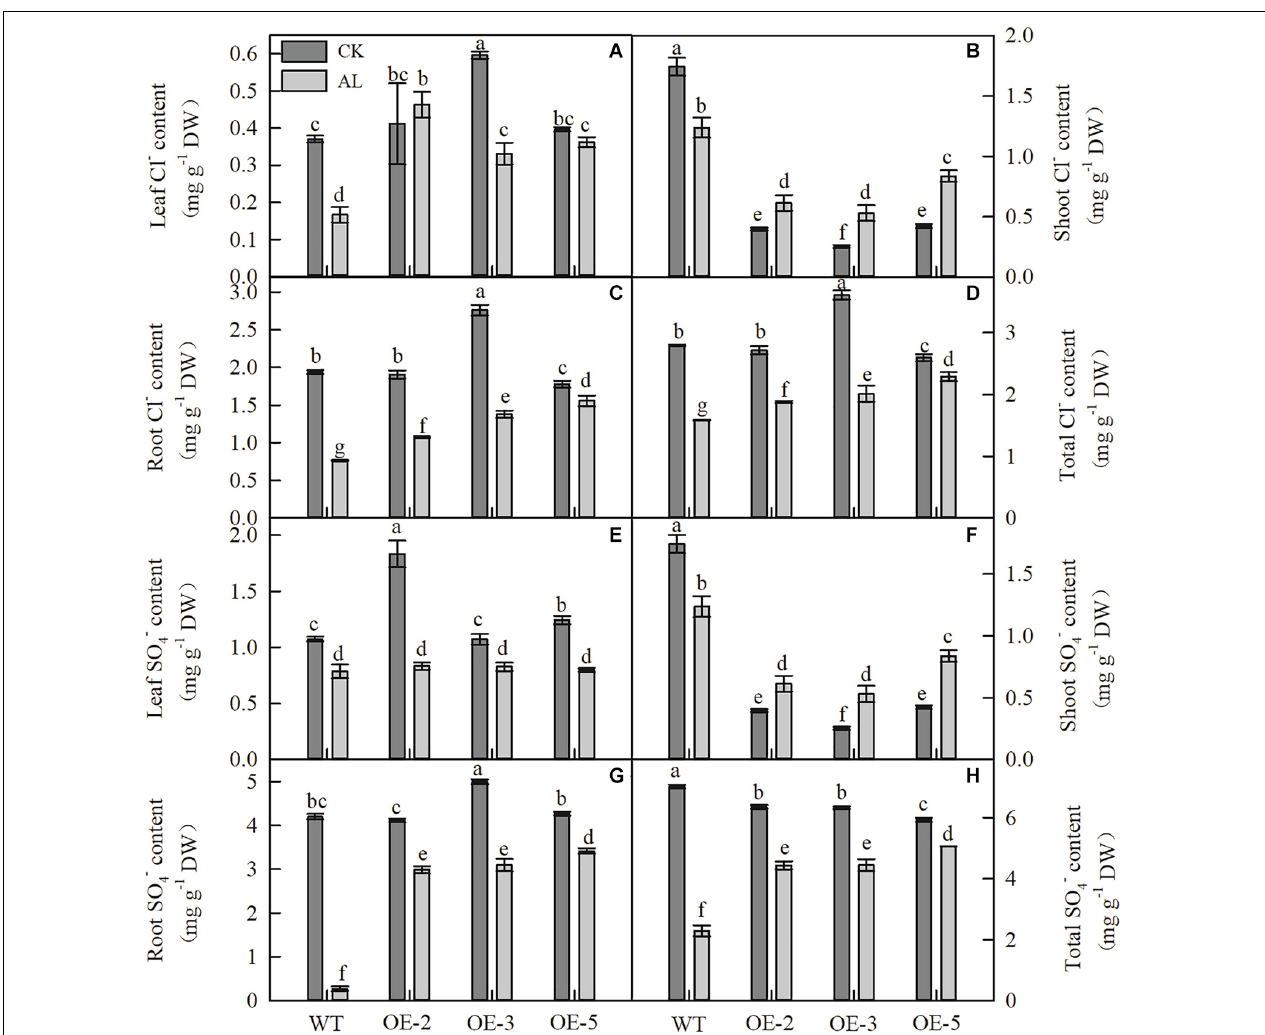
FIGURE 6 | MdTyDc overexpression changed the Cl − and SO 42 − content in apple plants after 15 days under control and alkaline conditions. (A) Leaf Cl − content, (B) shoot Cl − content, (C) root Cl − content, (D) total Cl − content, (E) leaf SO 42 − content, (F) shoot SO 42 − content, (G) root SO 42 − content, and (H) total SO 42 − content. The data are presented as means ± SD ( n = 3). Significant differences between WT and MdTyDc overexpression lines are indicated by different lowercase letters based on Tukey’s multi-range test ( P < 0.05). WT, wild type. OE-2, MdTyDc overexpression line 2. OE-3, MdTyDc overexpression line 3. OE-5, MdTyDc overexpression line